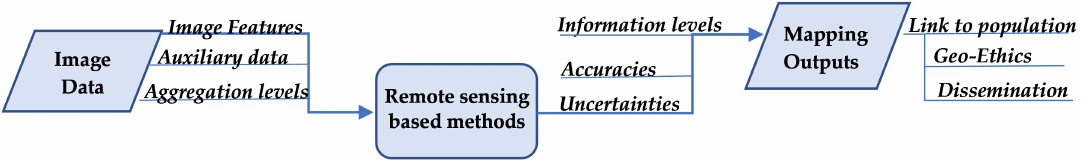
Figure 2. Overview of methodological steps and aspects to utilize remote sensing for the SDG indicator